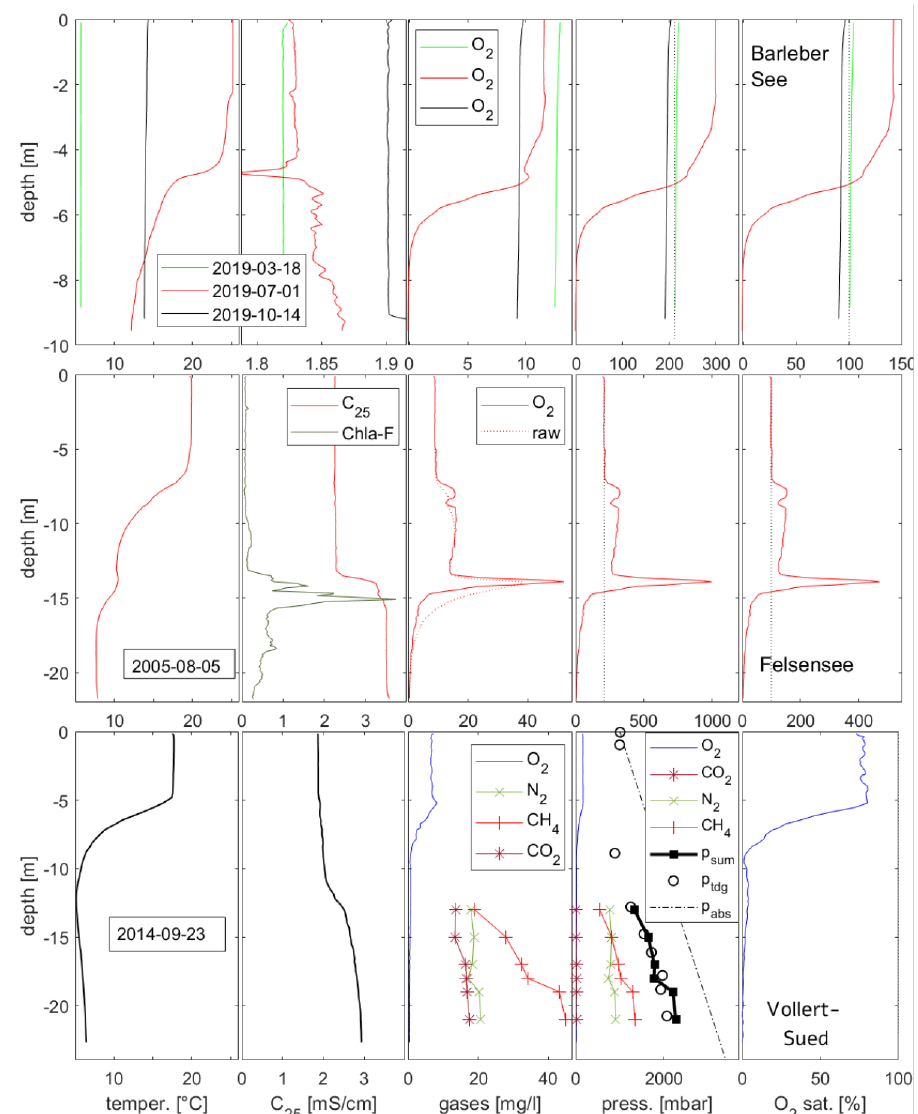
Figure 4. Profiles from the lakes: Barleber See, Felsensee, Vollert-Sued showing measured profiles of temperature, el. conductivity, gas concentrations, gas pressures (dotted line: atmospheric O 2 partial pressure above lake surface) and oxygen saturation (dotted line: 100% saturation). Felsensee O 2 data have been compensated for 6.5 s response time of the amperometric sensor from raw data. Vollert-Sued: p sum : sum of calculated gas pressures; p tdg : directly measured total gas pressure; p abs : absolute pressure calculated as atmospheric plus